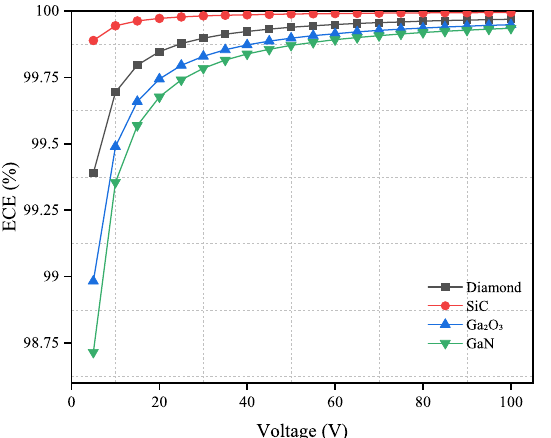
Figure 8. Electron collection efficiency (%) versus applied voltage for diamond, SiC, Ga 2 O 3 and GaN semiconductor materials. The thickness for four materials are shown in Table 4.